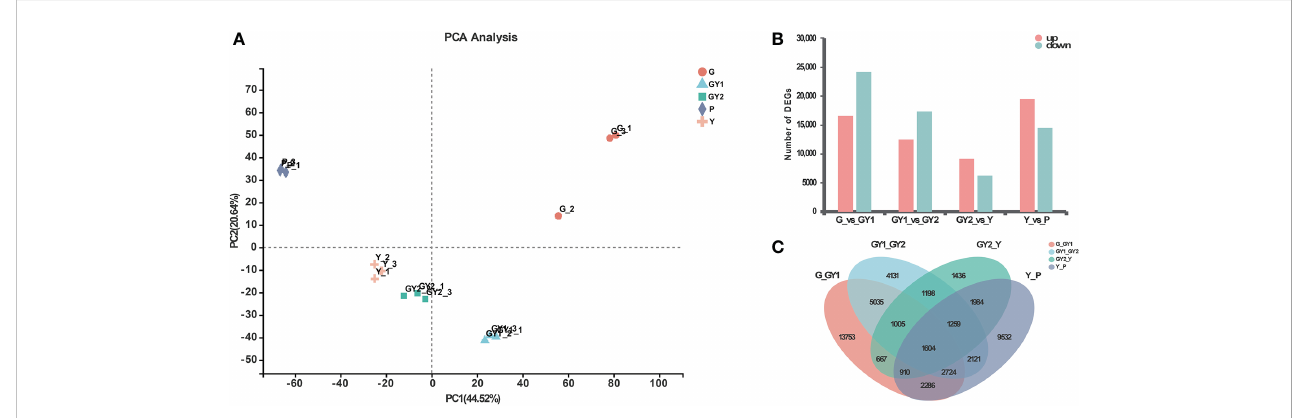
FIGURE 3 Differentially expressed genes (DEGs) at fi ve stages of anther development in Lilium Oriental Hybrid ‘ Siberia ’ . (A) Principal component analysis of different samples. The horizontal axis is the contribution of principal component 1, and the vertical axis represents the contribution of principal component 2. (B) Numbers of upregulated and downregulated DEGs in pairwise comparisons of fi ve developmental stages: G- vs .-GY1, GY1- vs .-GY2, GY2- vs .-Y, and Y- vs .- P. (C) Venn diagram of the data presented in (B)